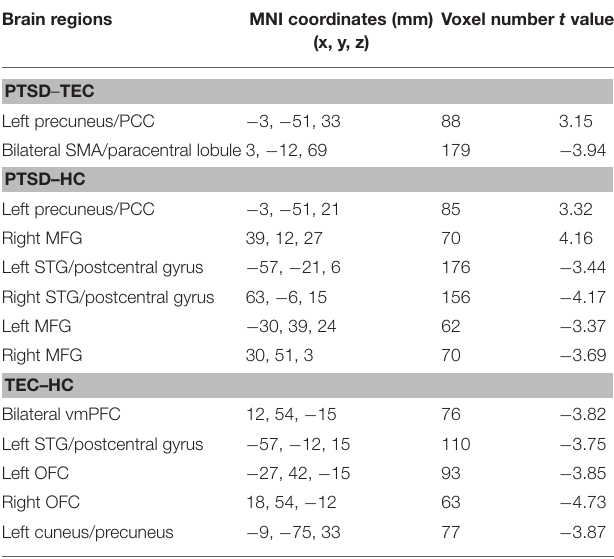
TABLE 5 | Comparison of effective connectivity to the right amygdala. Brain